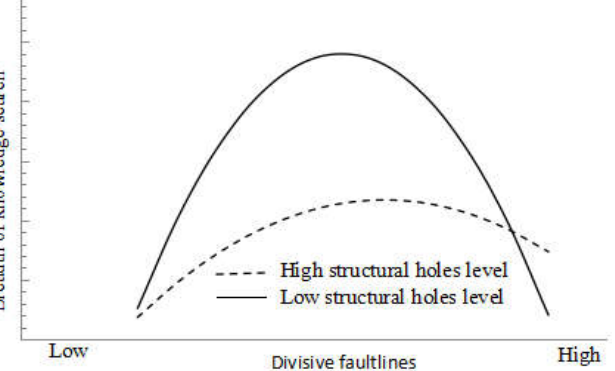
Figure 3. The moderating effect of structural holes on the divisive faultlines and the breadth of the knowledge search.